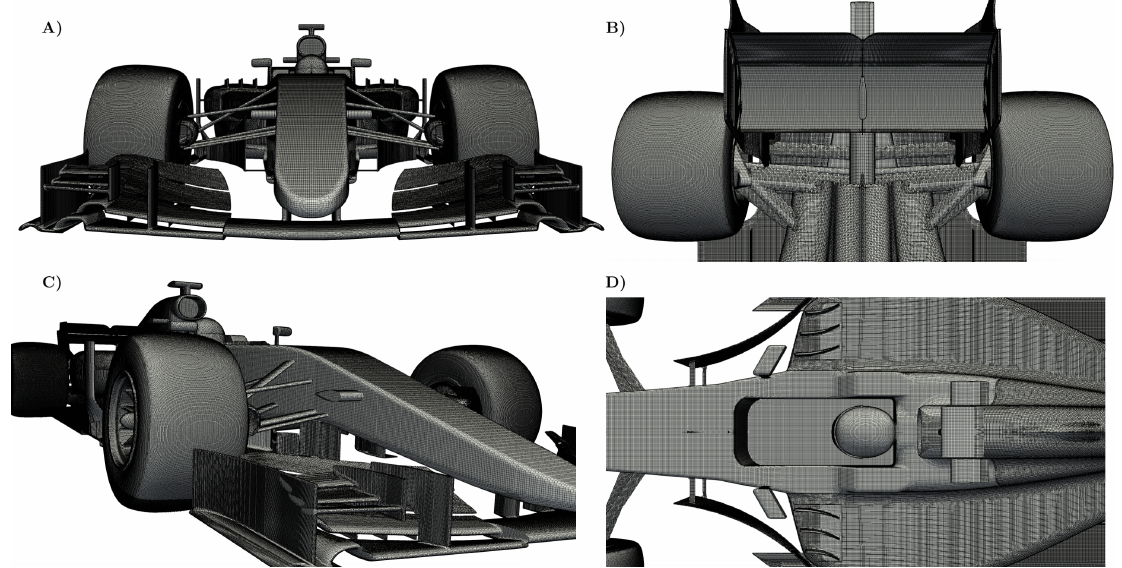
Figure 6. Mesh ( A ) front, ( B ) rear wing, ( C ) trimetric, and ( D )